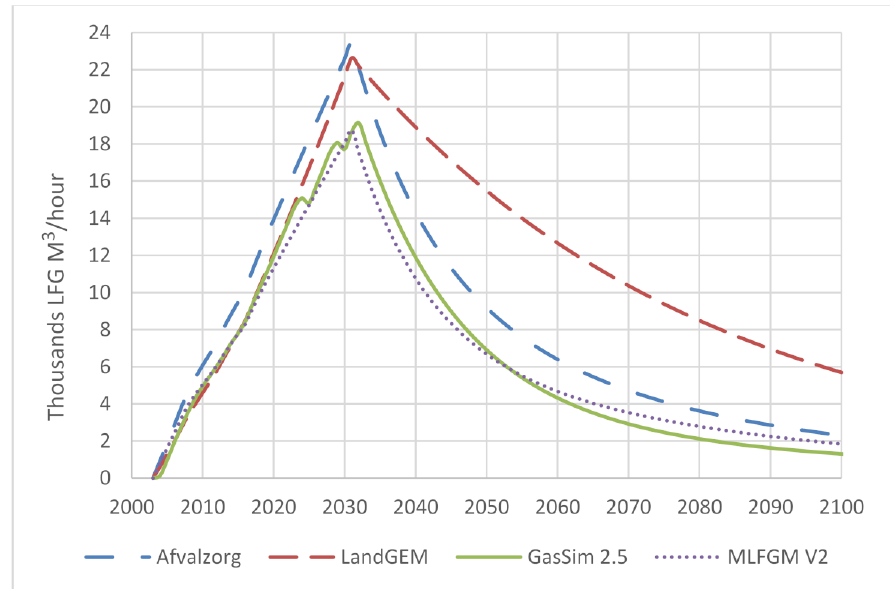
Figure 3. Al-Ghabawi landfill LFG production using FOD models until the year 2100.